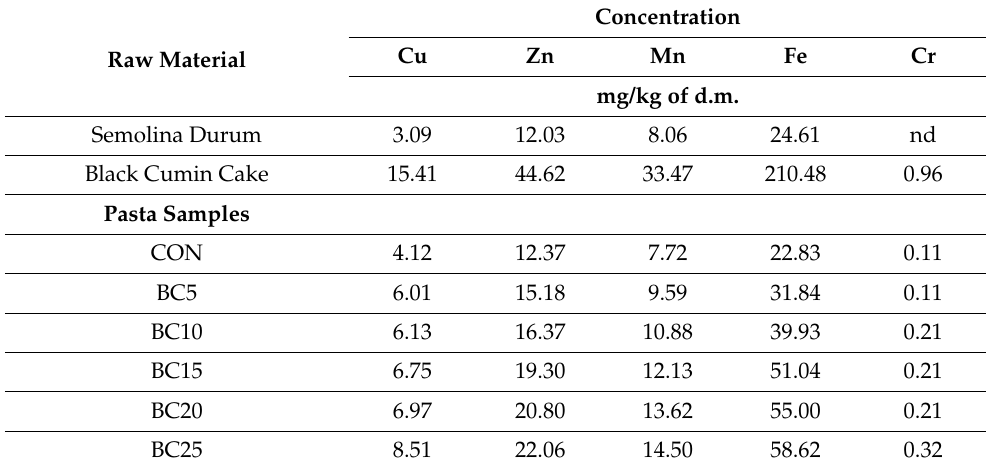
Table 3. Chemical elements in the raw materials and pasta